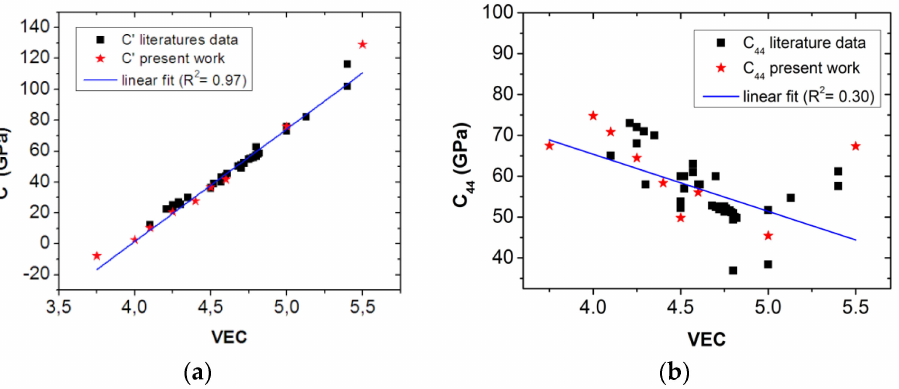
Figure 1. The C (cid:48) component of G changes linearly ( a ), whereas C 44 does not correlate ( b ) with the VEC